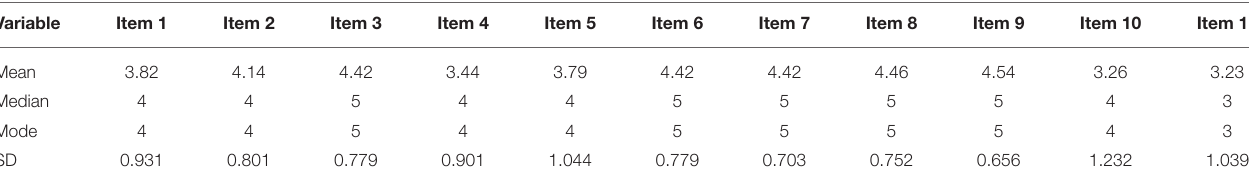
TABLE 3 | Descriptive statistics for each individual item of FLE ( N =